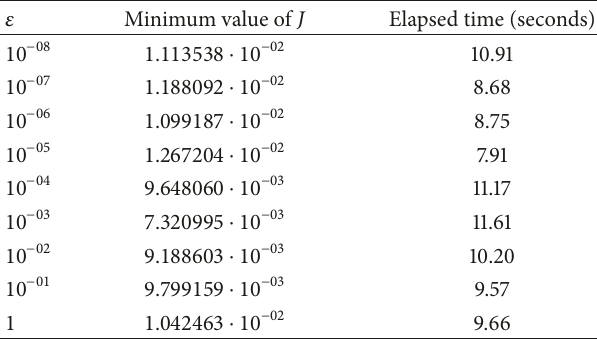
Table 3: Results on the Tikhonov aporoach. Comparison between different values of regularizing coefficient 𝜀 . The smallest value of 𝐽 is reached when 𝜀 = 10 −03 .